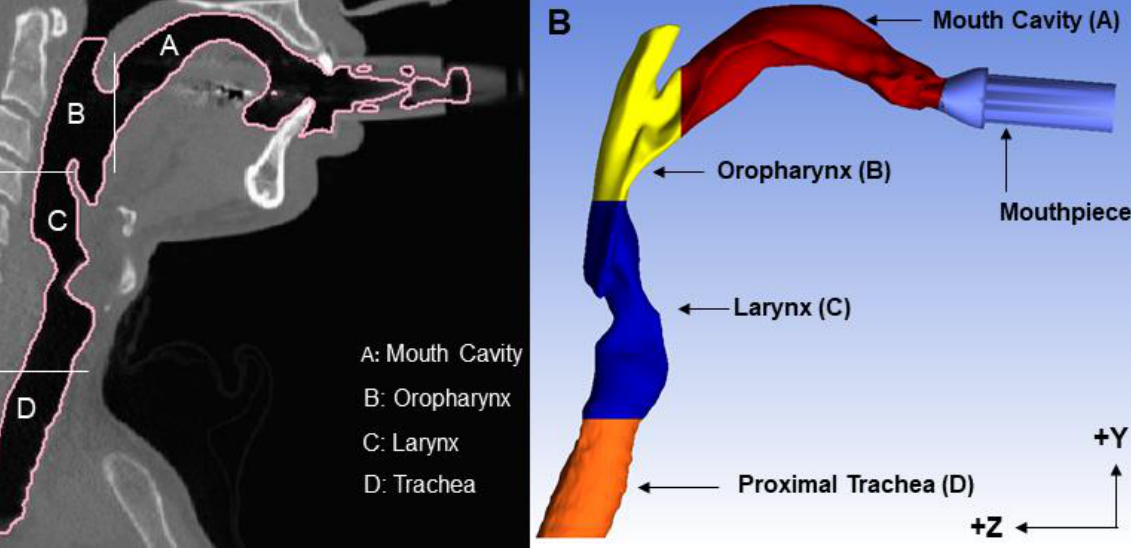
Figure 1. Definition of the subregions of the upper airway ( A ) CT scan of the oral airway of subject H1. ( B ) Reconstructed 3D model. The mouth is the oral cavity that extends from the back of the teeth to the uvula. The oropharynx region is the cavity from the back of the uvula to the tip of epiglottis. The larynx region is from the tip of the epiglottis to below the vocal cords and top of the trachea. The Z direction indicates the direction of gravity.